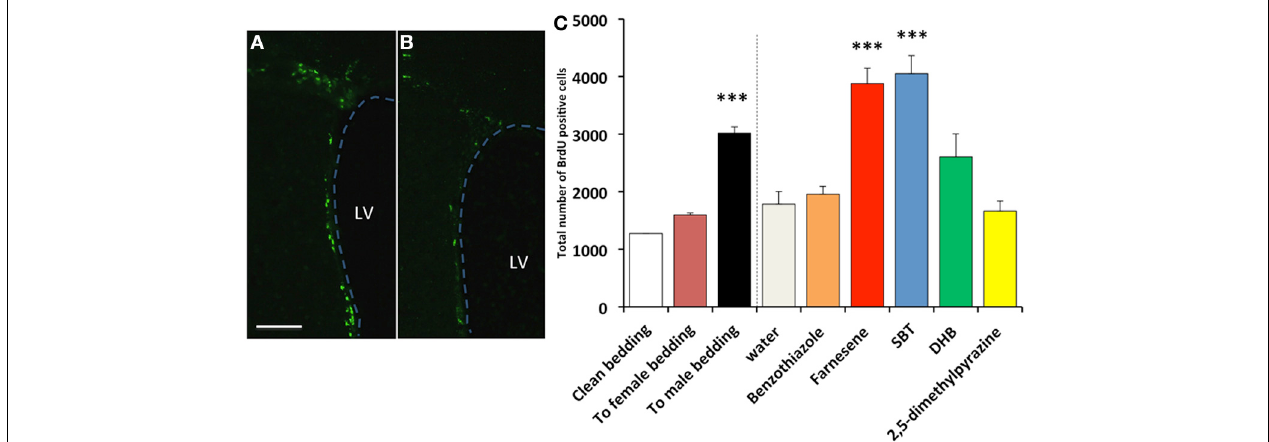
in the SVZ than the females exposed to clean bedding ( n = 5) ( P < 0 . 001). Female mice exposed to farnesene ( n = 8) and SBT (“SBT,” n = 6) showed higher cell proliferation than females exposed to water ( n = 4). Females exposed to dehydro-exo-brevicomin(“DHB”, n = 6), 2,5-dimethylpyrazine ( n = 4), or benzothiazole ( n = 5) did not show enhanced cell proliferation in the SVZ compared to females exposed to water. ∗∗∗ : significantly higher than control P < 0 . 001, Dunnett test.